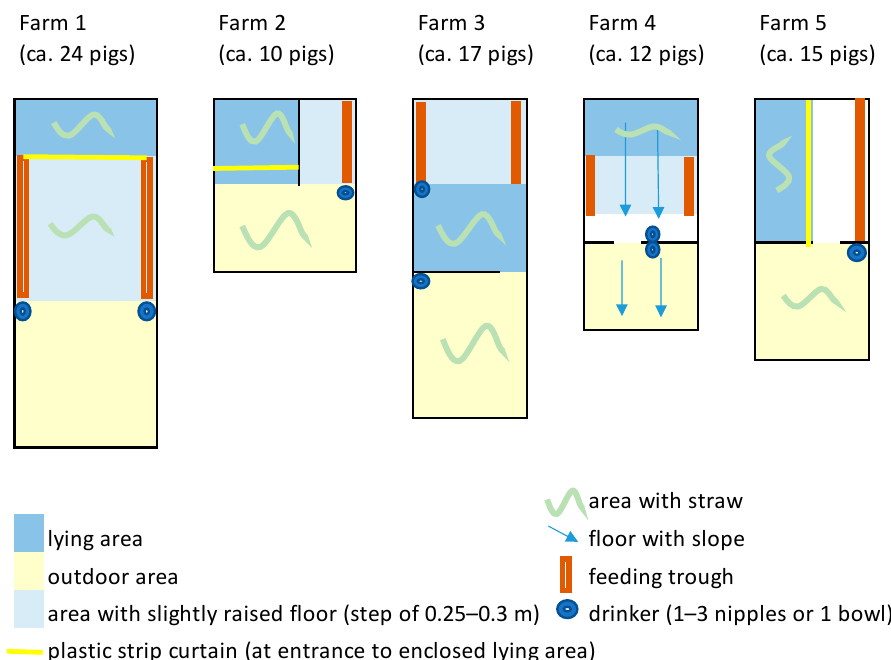
Figure 1. Pen design at the 5 farms.